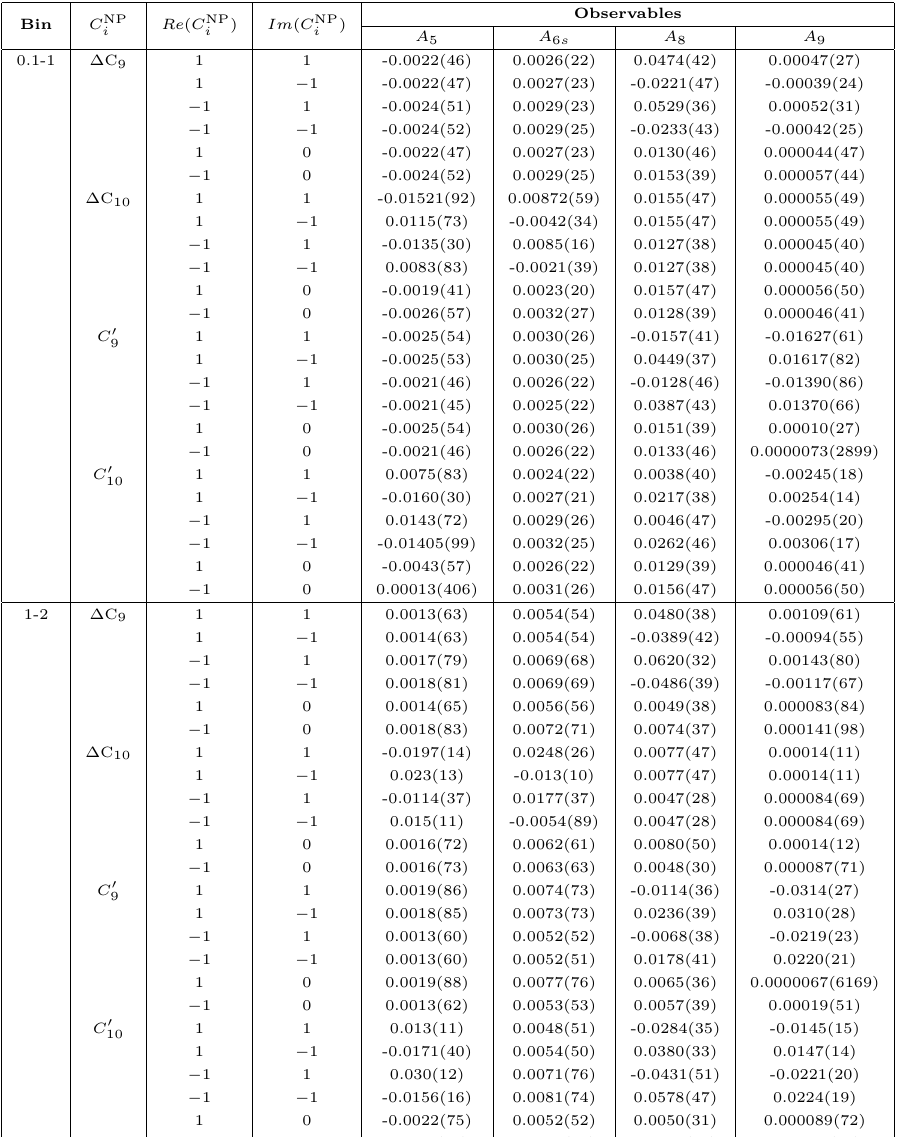
¯ B ( B ) → ρ 0 ll on the and C 0 for the q 2 bins 0 . 1 − 1 and 1 − 2 GeV 2 9 , 10 9 , 10